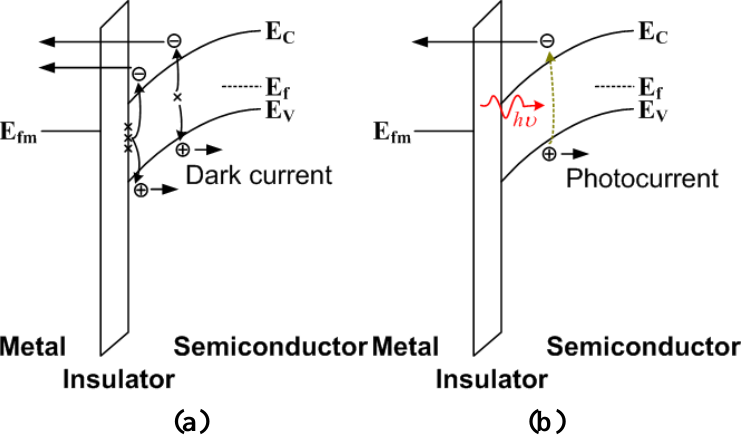
Figure 3. The current mechanisms of an MIS diode (a) without light illumination; (b) with light illumination. A positive bias (inversion bias) is applied for this metal/insulator/p-type semiconductor example.